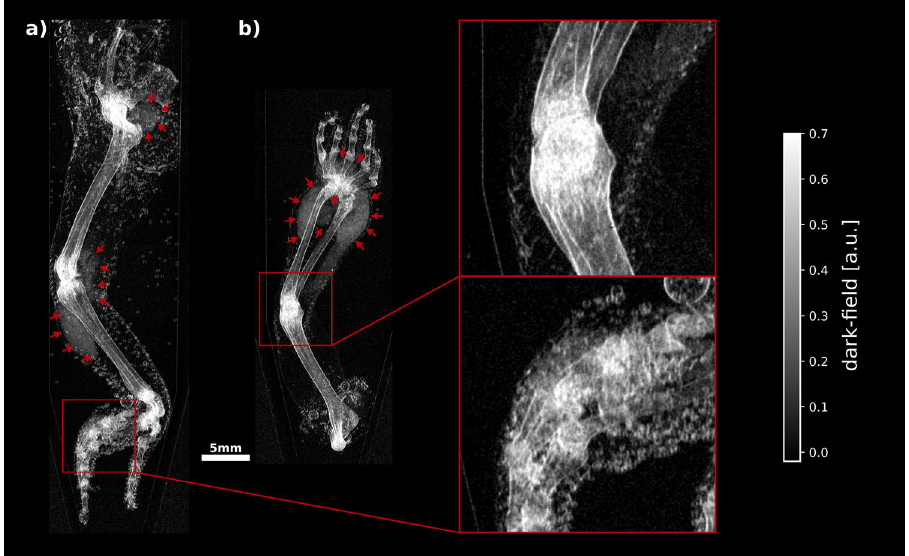
Figure 5. Exemplary darkfield image of two sample in which not all MSU deposits could be detected by the radiologists. The hind limb of animal #5 ( a ) contained MSU deposits in three different regions: Hip, knee (indicated by red arrows) and the metatarsophalangeal joints (red box). All regions show a more or less increased dark-field signal. From the zoom-in box it is clear that the detection of such areas can be